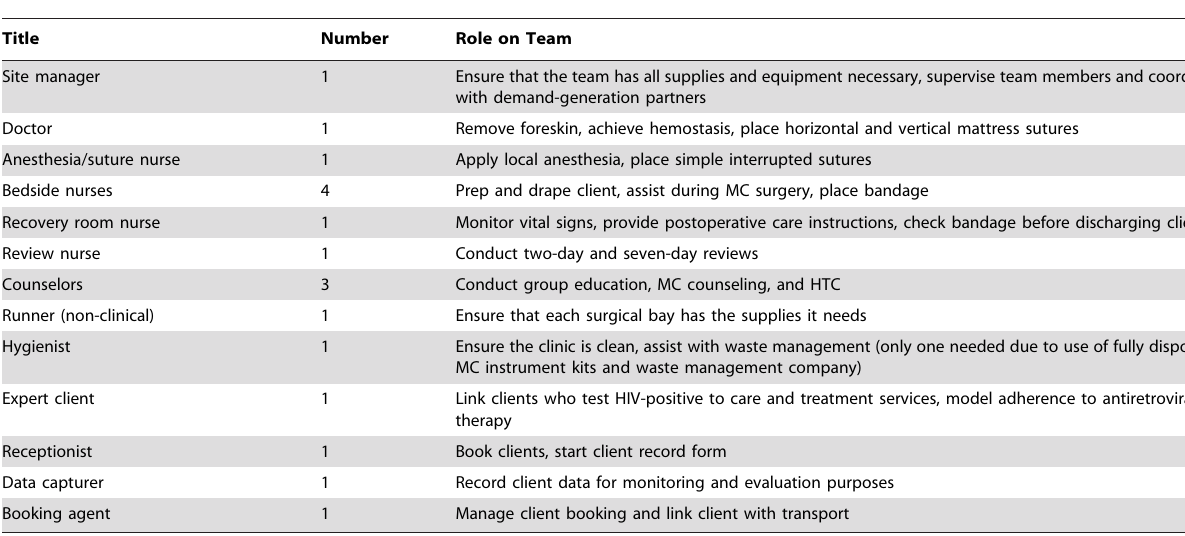
Table 2. Composition of VMMC clinical teams in Swaziland initiative.